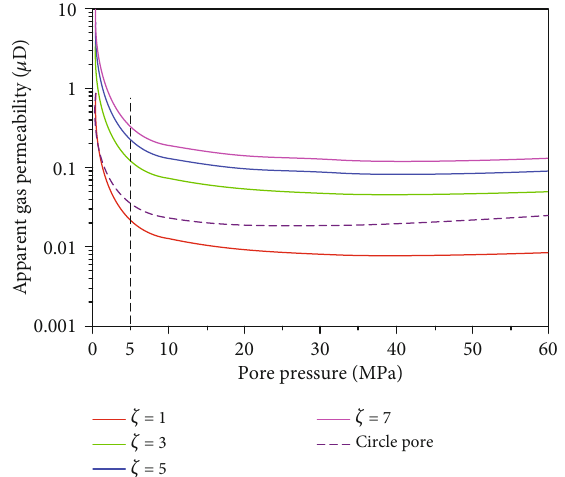
Figure 11: The impact of pore geometry on gas fl ow ( H